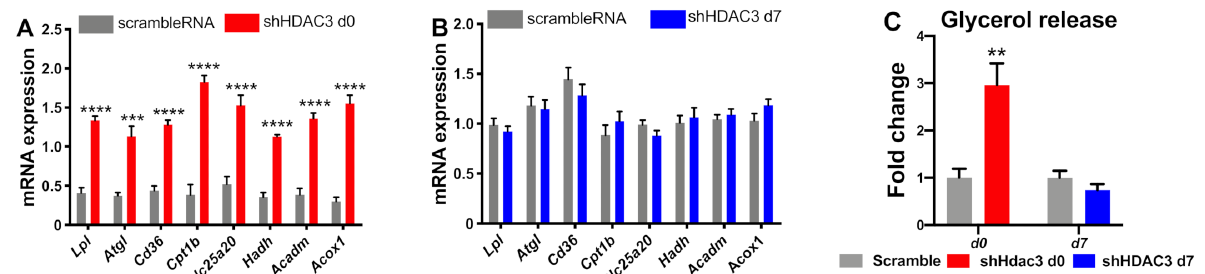
Figure 5. Expression of genes relevant for lipid mobilization and fatty acid β -oxidation in C3H/10T1/2 cells infected with scramble/shHDAC3 at day 0 ( A ) or at day 7 ( B ) of differentiation to adipocytes. Glycerol release from adipocytes in the culture medium ( C ). Cells silenced at day 0 were harvested at day 9 after induction of differentiation, while cells silenced at day 7 were harvested at day 11 after induction of differentiation. Data are presented as mean ± SEM. Statistical analysis was performed with GraphPad PRISM using unpaired Student’s t -test, ** p < 0.01, *** p < 0.001, **** p < 0.0001 ( n ≥ 6 from at least 2 independent